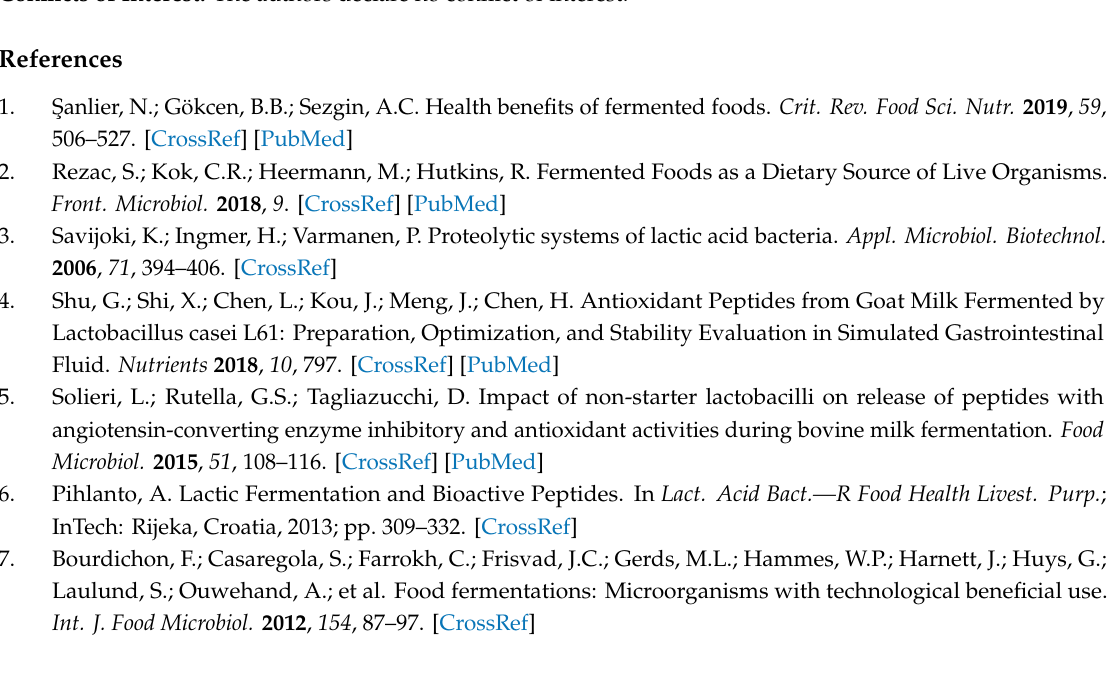
Figure S1: Fraction 6 uptake from Caco-2 cell monolayer. Cells were incubated in the presence of fraction 6 (150 µ g) and the analysis of Apical (AP) and basolateral (BL) compartments was performed at the indicated time. Figure S2: Alignments between the reference proteins and the peptides identified by Proteome Discoverer and Mascot search. Oxidized methionine residues are indicated in lowercase (m); #PSM values are indicated in brackets near to each peptide sequence. The alignments are reported separated for each reference protein. Table S1: Files from ORBITRAP analysis of fraction